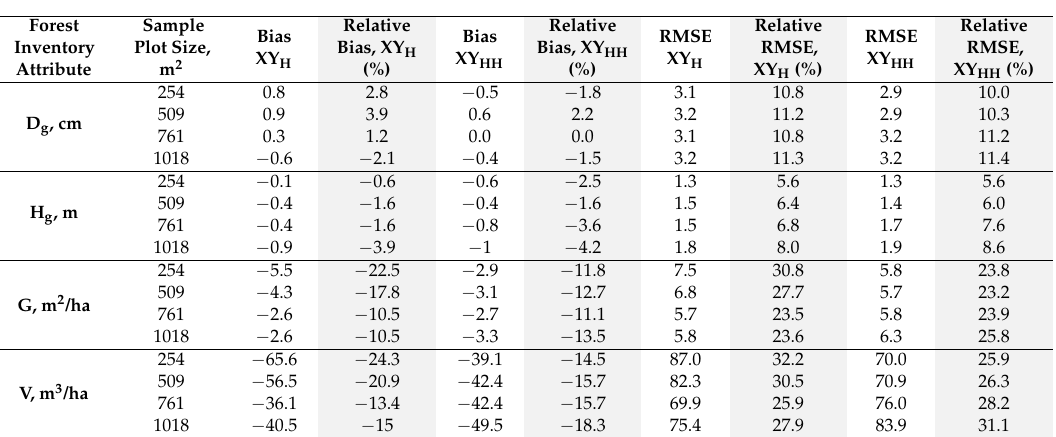
Table 2. Accuracies of the stand level ( n = 150) predictions for D g , H g , G, and V. Predictions were made using two different single-tree positioning methods for deriving forest inventory attributes for sample plots (XY H , XY HH ) and with four different sample plot